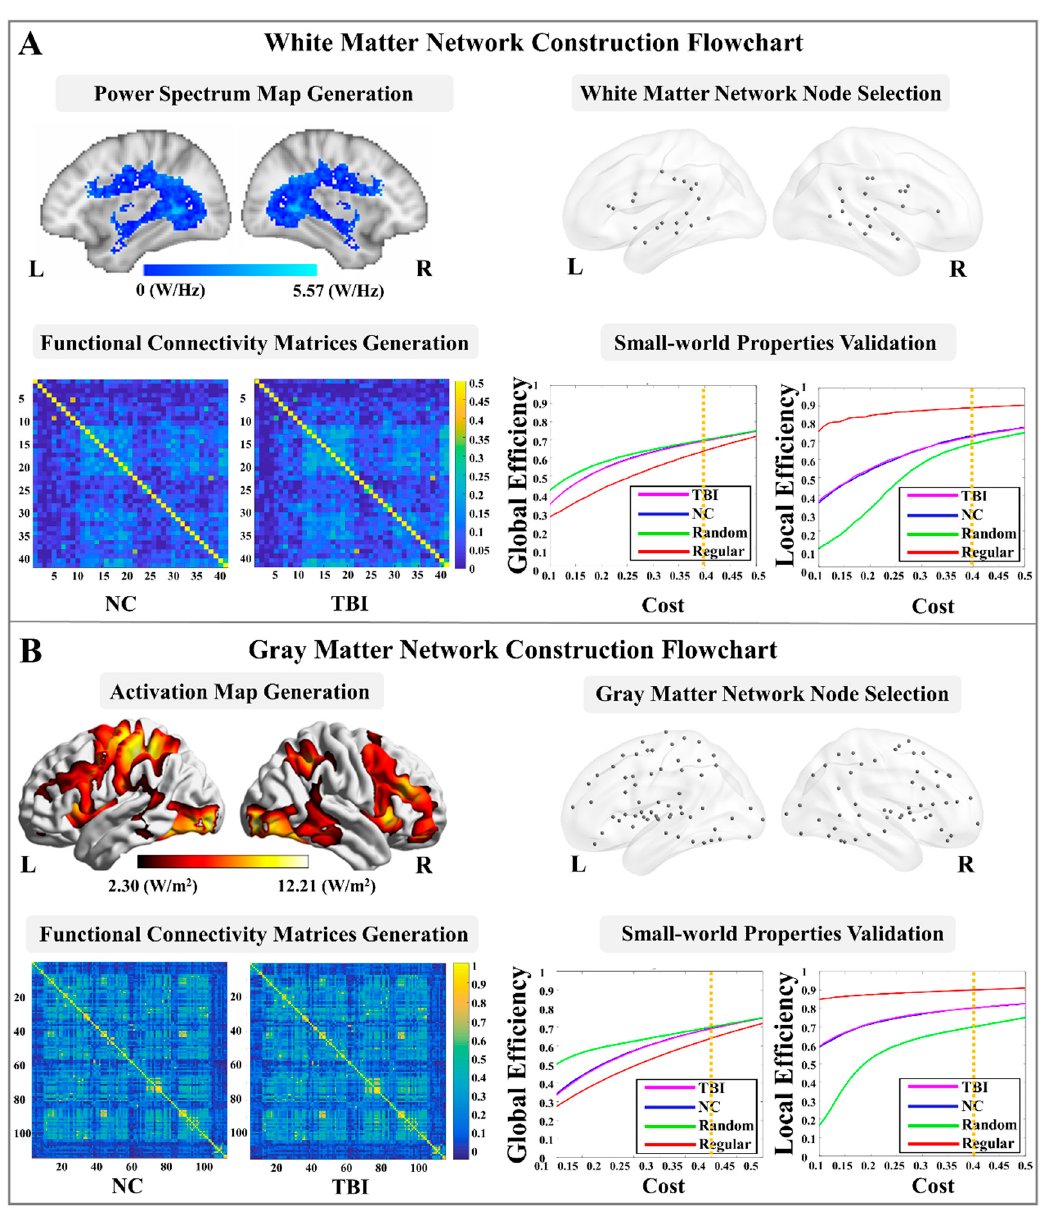
Figure 1. White matter and gray matter functional networks construction. ( A ) White matter net- work construction flowchart, including power spectrum map generation, node selection, functional connectivity matrices generation, and brain network small-world properties validation; ( B ) Gray matter network construction flowchart, including brain activation map generation, node selection, functional connectivity matrices generation, and brain network small-world properties validation. (L: left hemisphere; R: right hemisphere; NC: normal control; TBI: traumatic brain